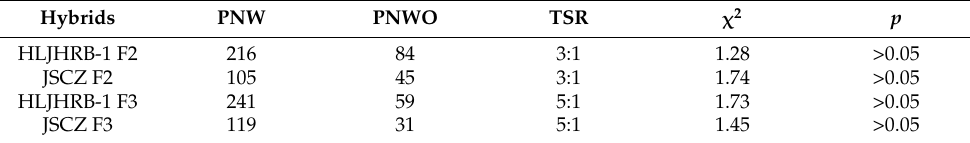
Table 1. Analysis of hybrids carrying cp4-epsps gene and χ 2 test of F2, F3 hybrids.